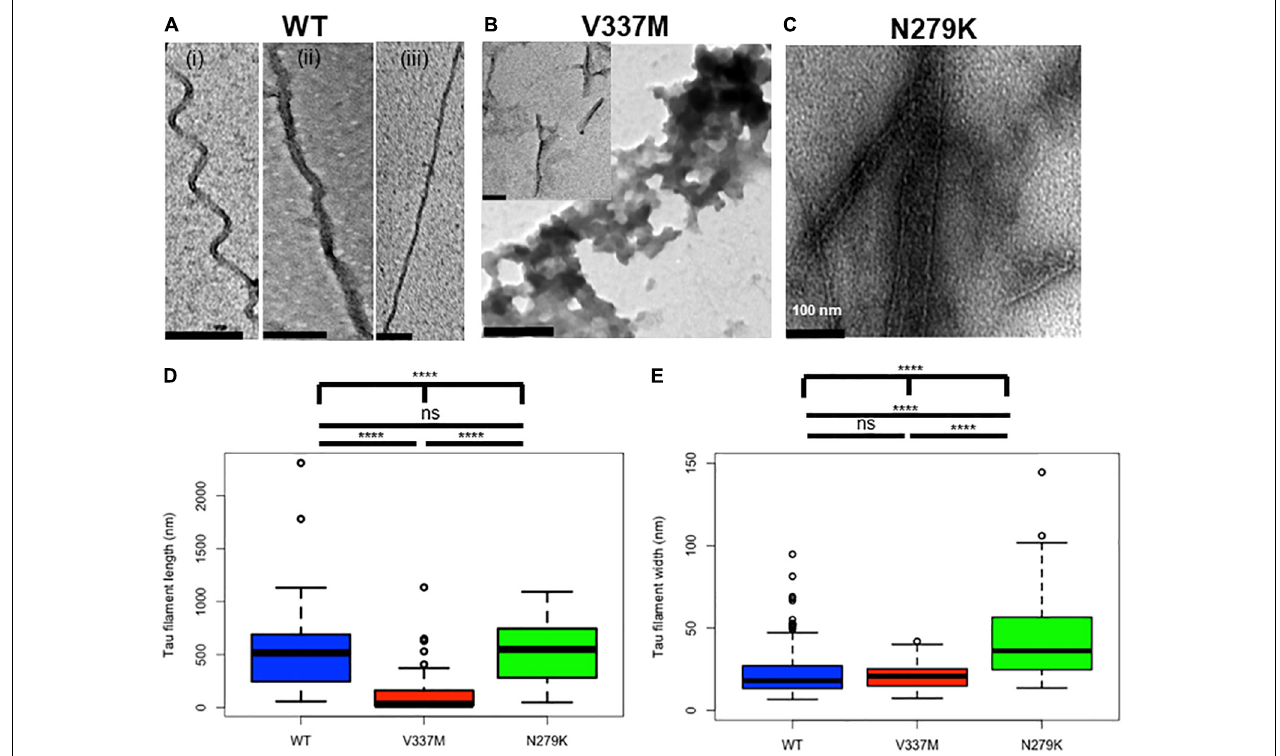
FIGURE 2 | Structural changes in tau K18 filaments formed in the presence of the V337M and N279K FTD mutations after 4 days of incubation. (A) Representative electron micrographs of K18-WT, showing PHFs and SFs. (B) Representative electron micrographs of K18-V337M, which formed amorphous aggregates and short filaments (examples shown in the main figure and inset, respectively). (C) Representative electron micrographs of K18-N279K, showing bundled filaments of different shapes and widths. Scale bar = 100 nm for all images. Extended examples of the tau aggregates shown here can be found in Supplementary Figure S1 . (D,E) Box plots of filament lengths and widths, respectively for the tau K18 variants. The plots show the results of a total of 73, 112, and 47 analyzed fibrillar structures for K18-WT, K18-V337M, and K18-N279K, respectively across n = 3 independent experiments using different batches of purified proteins. Kruskal–Wallis test followed by Dunn’s post hoc test; ∗∗∗∗ = p < 0.0001, ns, not significant.